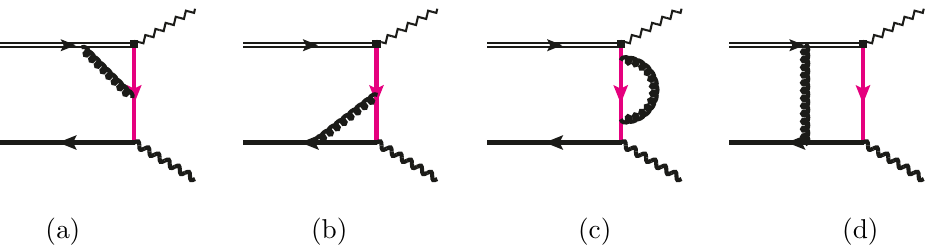
Figure 2 . Diagrammatical representation of the two-particle contribution to the vacuum-to- B - meson correlation function (cid:5) (cid:22) ( n (cid:1) p; (cid:22) n (cid:1) p ) de(cid:12)ned in (2.1) at O ( (cid:11) s ). (cid:12)gure 2 from the hard and hard-collinear regions. It is evident that the soft